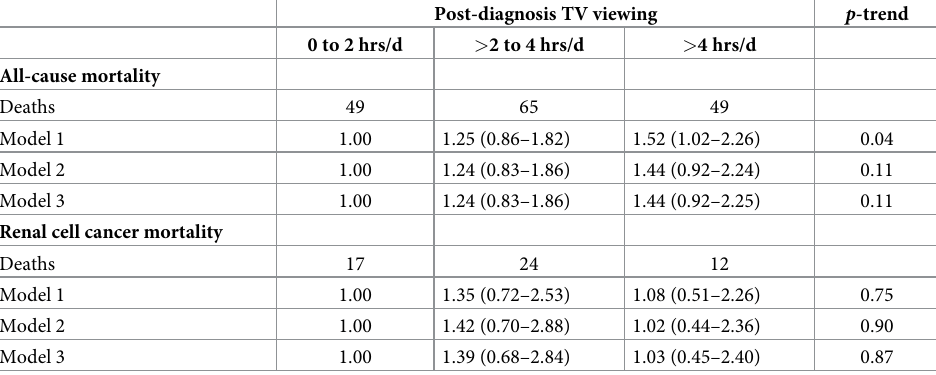
Table 3. Hazard ratios and 95% confidence intervals of mortality among individuals diagnosed with renal cell cancer according to post-diagnosis TV viewing.